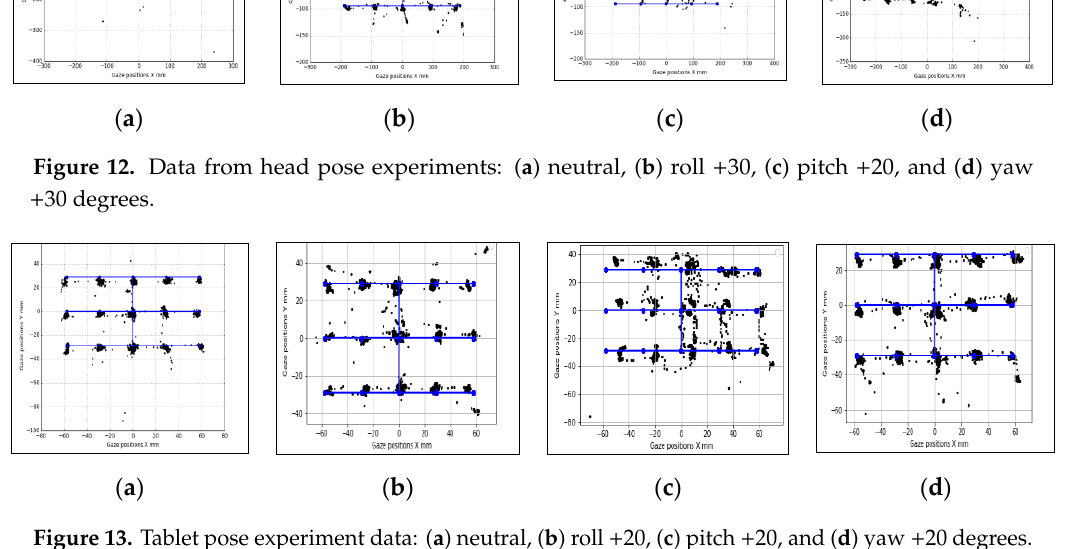
Figure 13. Tablet pose experiment data: ( a ) neutral, ( b ) roll +20, ( c ) pitch +20, and ( d ) yaw +20 degrees.